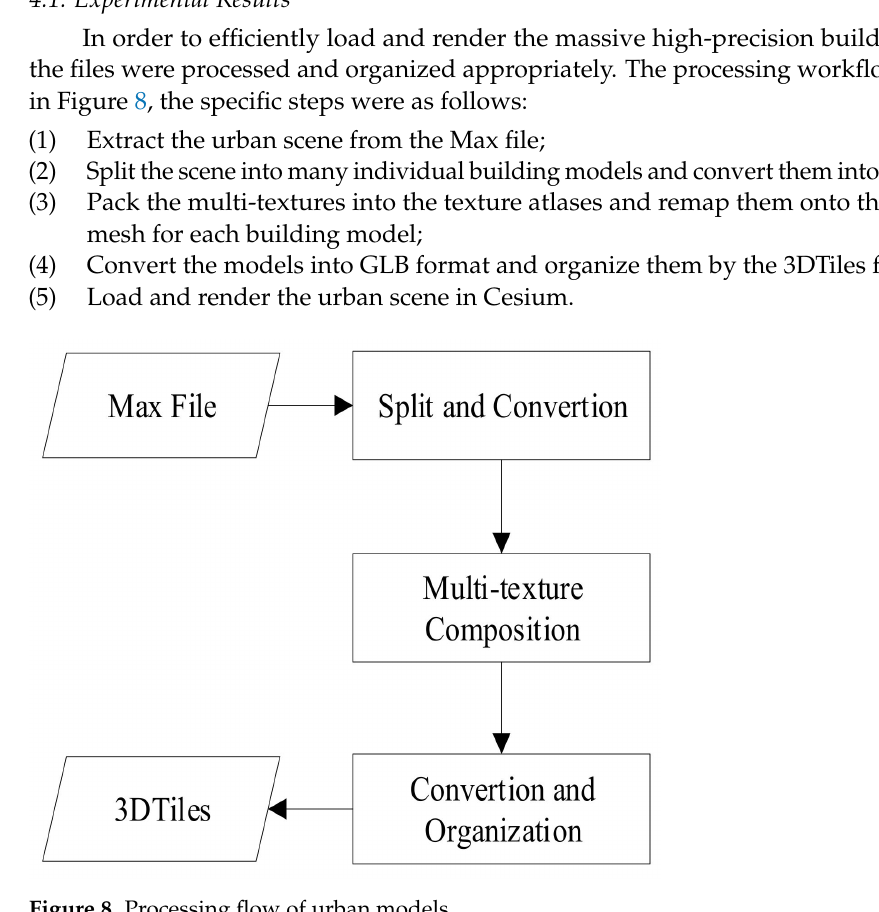
Figure 8. Processing flow of urban